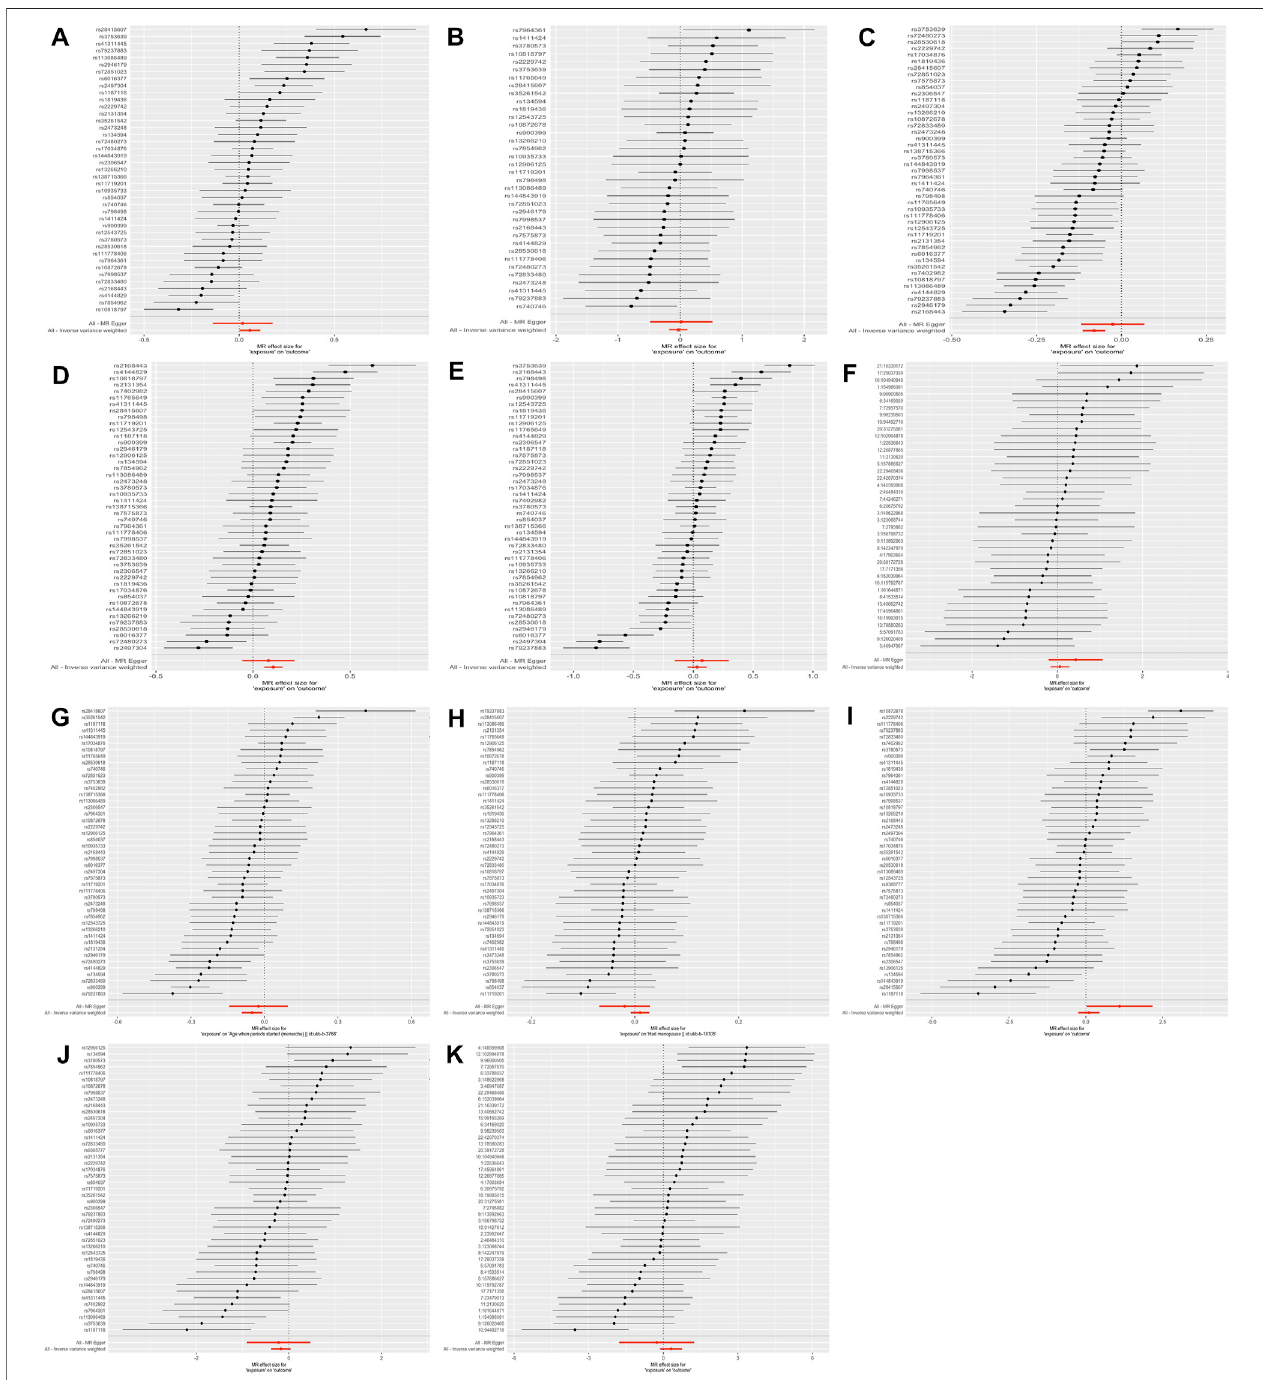
FIGURE 4 | The results of the forest